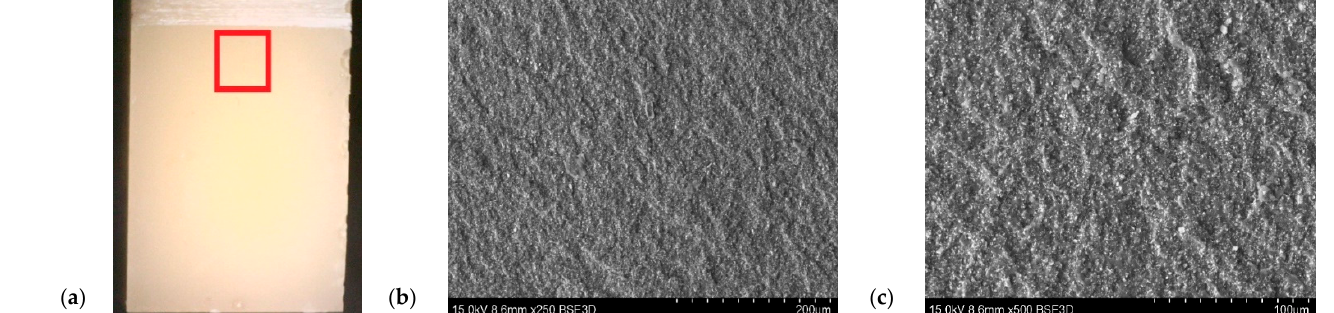
Figure 16. The fracture surface of resin with the addition of a filler 50 phr Al(OH) 3 . ( a ) Sample with marked SEM images location. ( b ) Fracture surface with magnification ×250. ( c ) Fracture surface with magnification ×500.